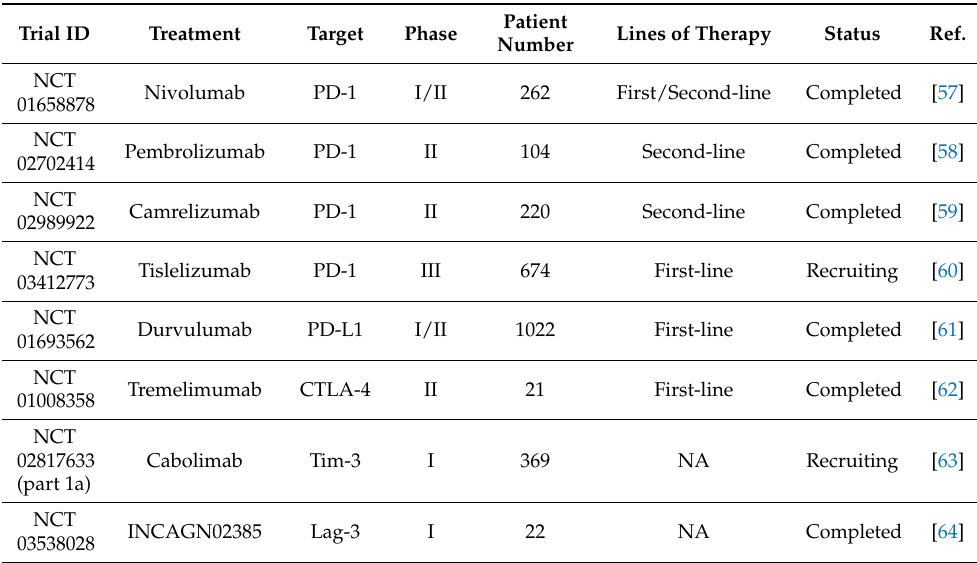
Table 1. Clinical trials investigating immune checkpoint inhibitor monotherapy in hepatocellular carcinoma.